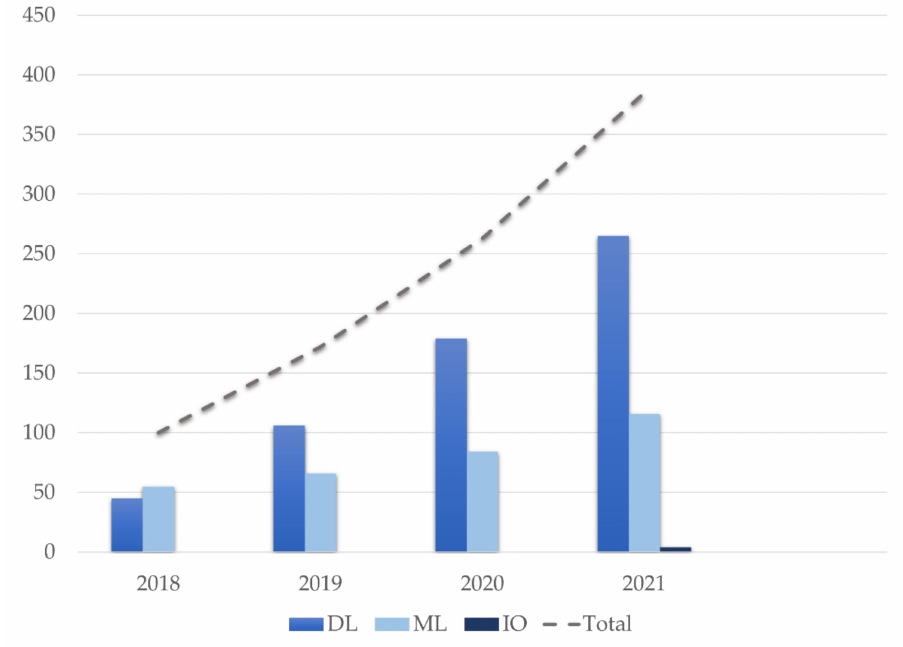
Figure 3. Papers per year according to the type of AI approach. The blue, cyan, and dark blue bars represent DL, ML, and IO methods, respectively. The grey line represents the total count (i.e., the sum of DL, ML, and IO methods) per